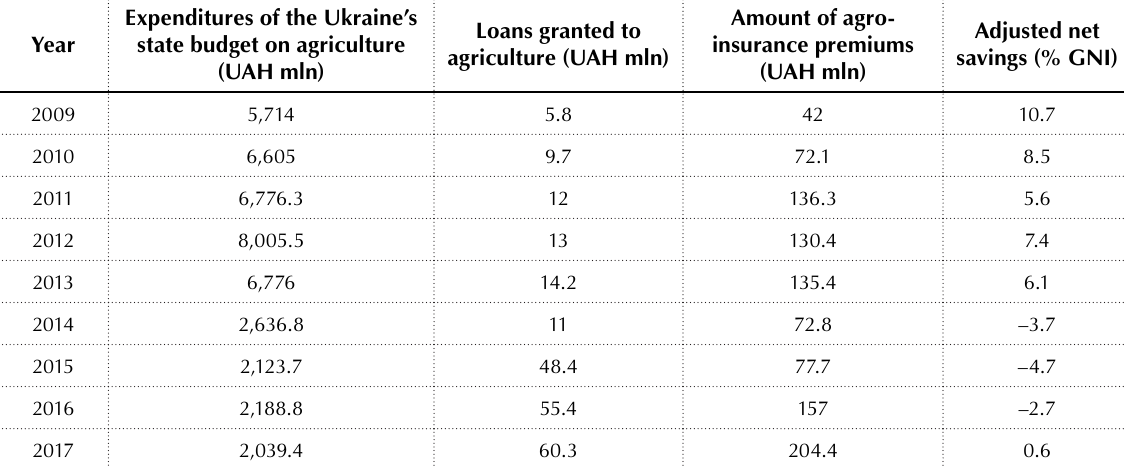
Table 1. Funding allocation for agriculture in Ukraine during